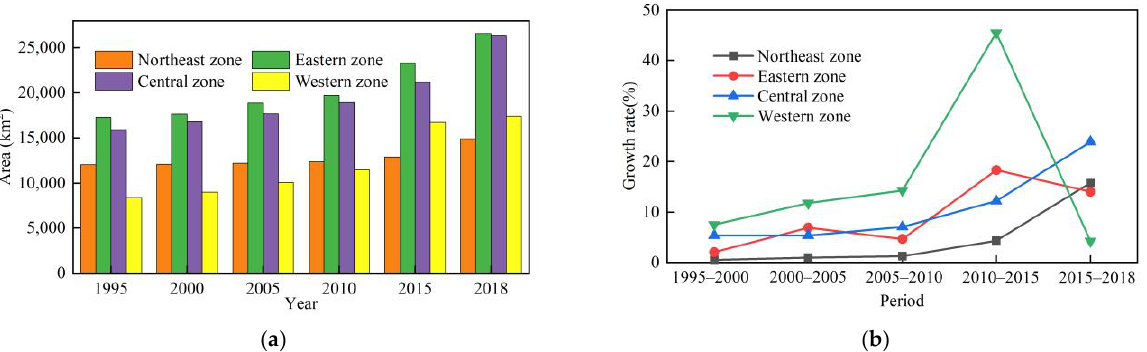
Figure 5. Change in construction land in the RBCs in the different regions. ( a ) Construction land area; ( b ) growth rate of construction land.